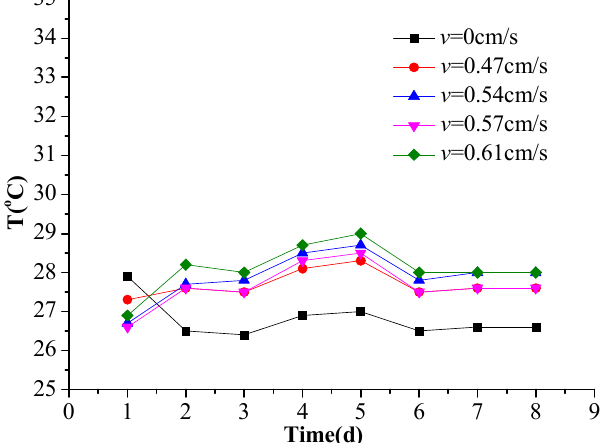
Figure 3. Plot of overlying water temperature for different flow rates during the experiment.